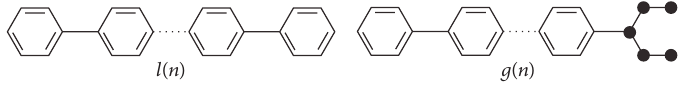
Figure 2: Chains 𝑙(𝑛) and 𝑔(𝑛) .